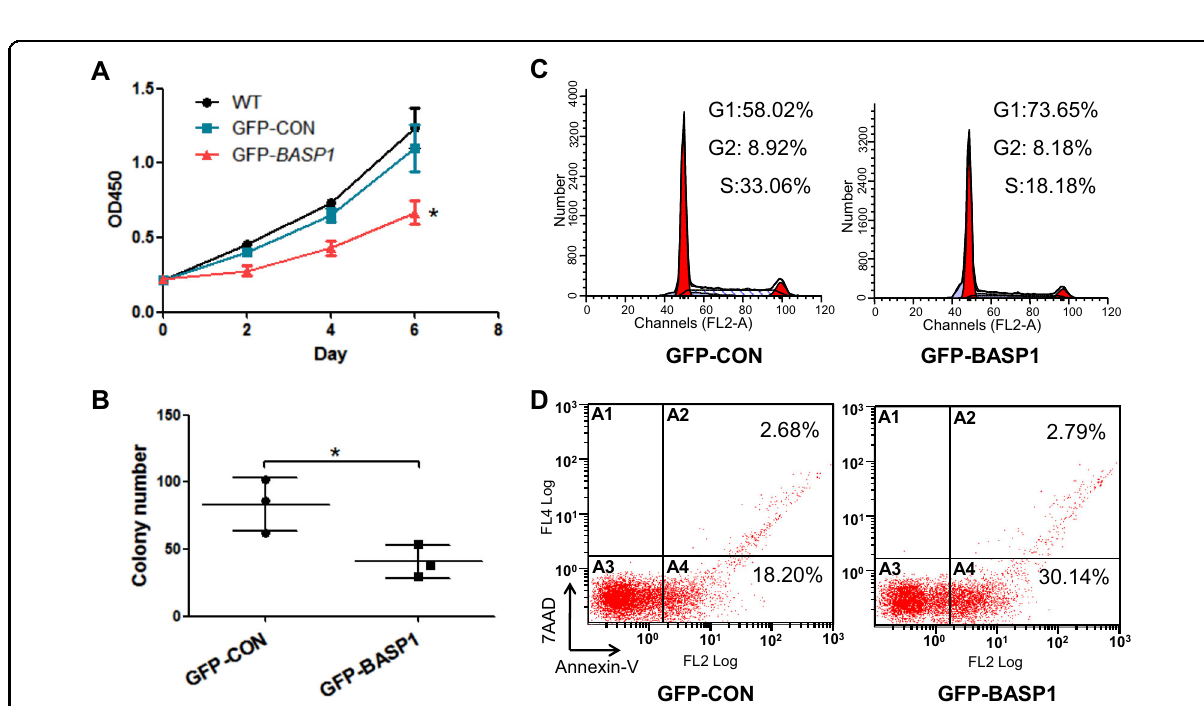
Fig. 4 Ectopic expression of BASP1 in SKNO-1 cells inhibits proliferation, suppresses colony formation, and increases apoptosis and cell cycle arrest. a The CCK-8 assay was performed on SKNO-1 cells transduced with the GFP-tagged BASP1 lentiviral or GFP control plasmids at the indicated time points. b A colony formation assay was performed on SKNO-1 cells transduced with the GFP-tagged BASP1 lentiviral or GFP control plasmids and grown for 7 days. c Cell cycle analyses in SKNO-1 cells by fl ow cytometry showed that BASP1 overexpression induced the G1 phase arrest and blocked S-phase entry. d The induction of apoptosis in BASP1 overexpressing cells was measured using Annexin V-7AAD staining via fl ow cytometry. Error bars indicates the SD from three different assays (* p <